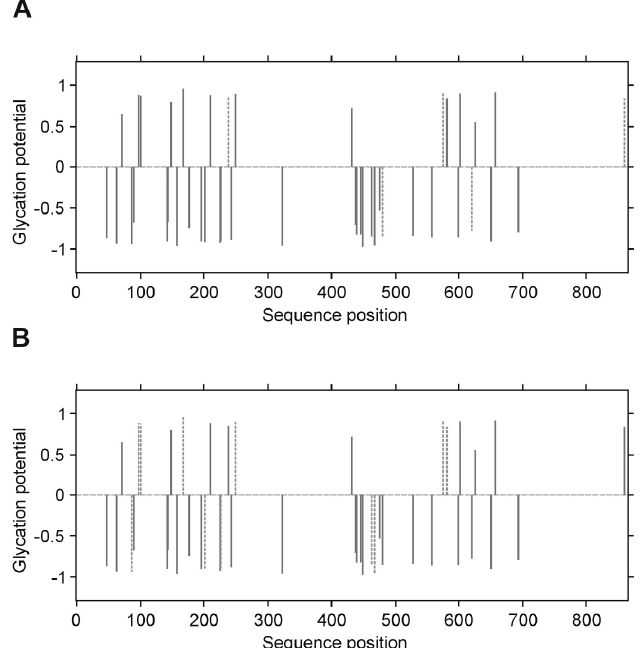
Figure 7. Predicted glycation sites in the α chain of human fibrinogen, evaluated by NetGlycate v1.0 software. Each plot presents the scores of glycation potential (bars), given for all 43 Lys residues of the α chain in control volunteers ( A ) and diabetic patients ( B ), which are relevant to the numbers between − 1 and 1 (threshold marked as grey dashed line); a score above 0 means that the residue is a predicted glycation site, while a score below 0 means that the residue is unlikely to be glycated. The bars marked by dashed thick lines denote the residues that were found to be really glycated in the examined subjects. Biomolecules 2020 , 10 , 877